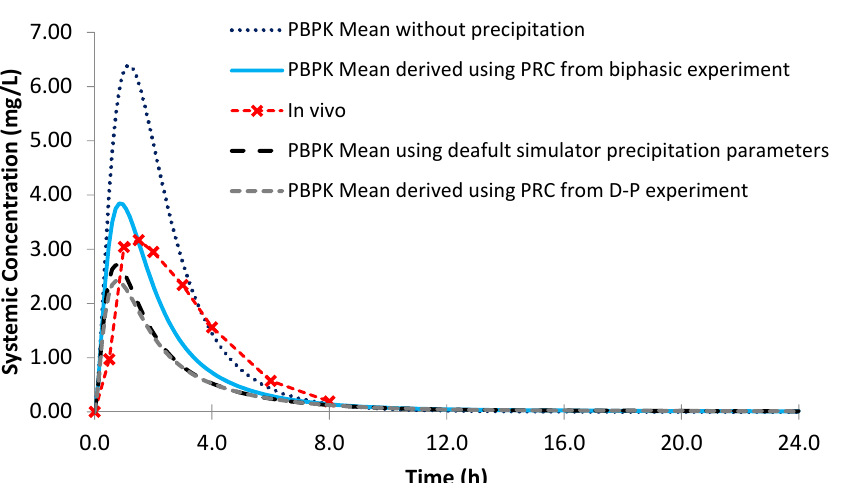
Figure 10. Simulated plasma profiles vs. in vivo plasma profile (dashed line with crosses) of dipyridamole after a single oral dose of dipyridamole 75 mg, based on the design of the clinical study by Ricevuti et al. [22]. The in vivo plasma profile is represented by the red dashed line with crosses. The simulated plasma profile derived from the biphasic dissolution data, the D-P data, the PBPK default simulator parameters and the profile without precipitation are represented by the solid blue line, the dashed grey line, the dashed black line and dotted dark blue line, respectively.